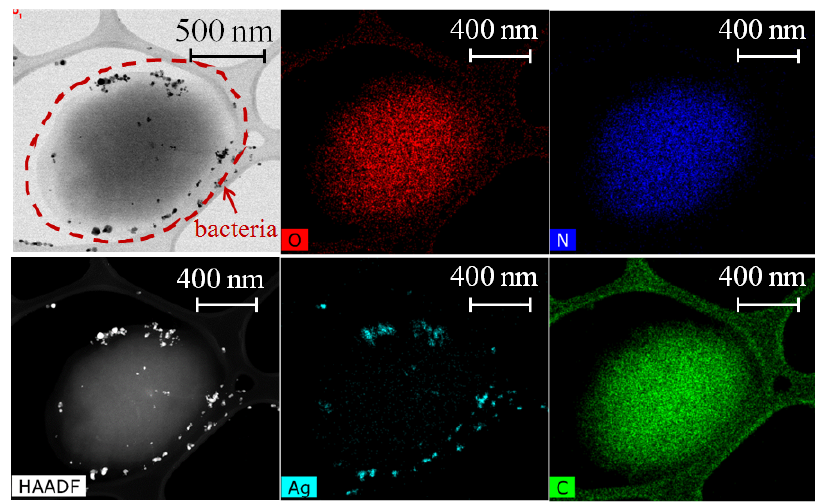
Figure 4. TEM image of S. aureus cells after treatment with AgNO 3 10.8 mM ‐ solution, distribution of elements in the sample, acquired by EDS and HAADF image.